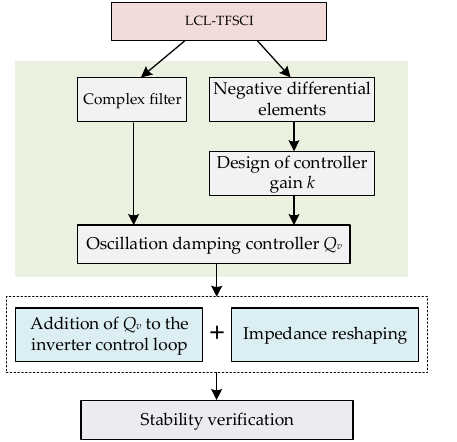
Figure 15. Design flow chart of the proposed oscillation-suppression method.